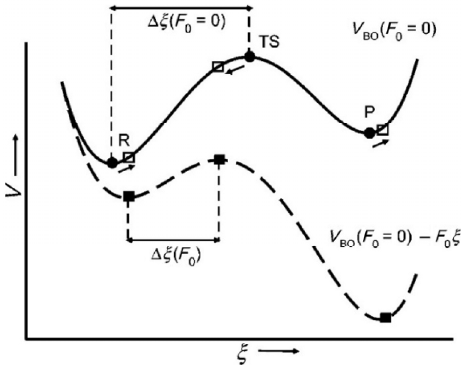
Fig. 19 Effect of a constant stretching force on a given reaction profile. Reproduced with permission from [109]. Copyright ACS,